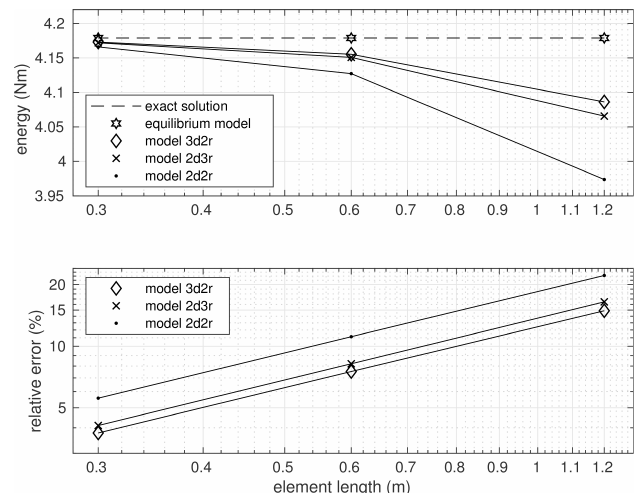
Figure 7. Strain energy and solution